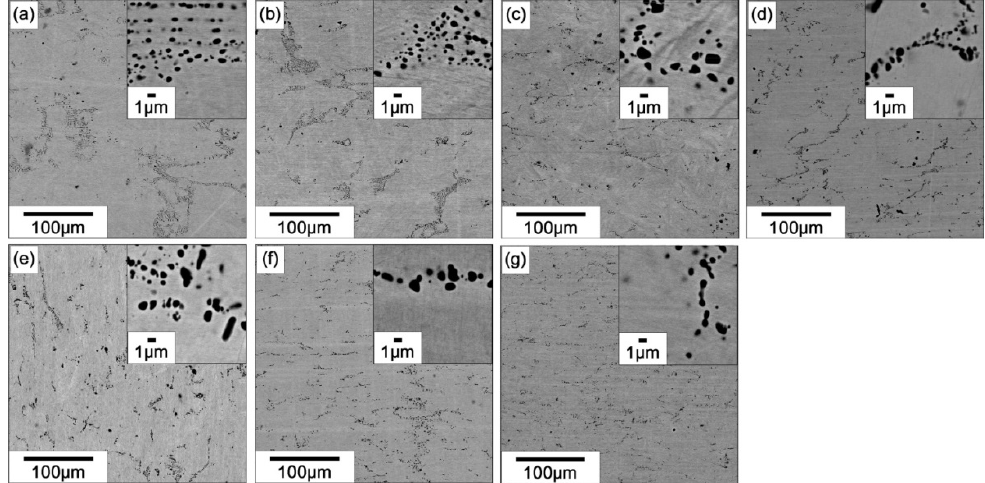
Figure 7. Back-scattered SEM images of the (49–52)Ti alloys solution treated at 1173 K. ( a ) 49Ti alloy; ( b ) 49.5Ti alloy; ( c ) 50Ti alloy; ( d ) 50.5Ti alloy; ( e ) 51Ti alloy; ( f ) 51.5Ti alloy; ( g ) 52Ti alloy.